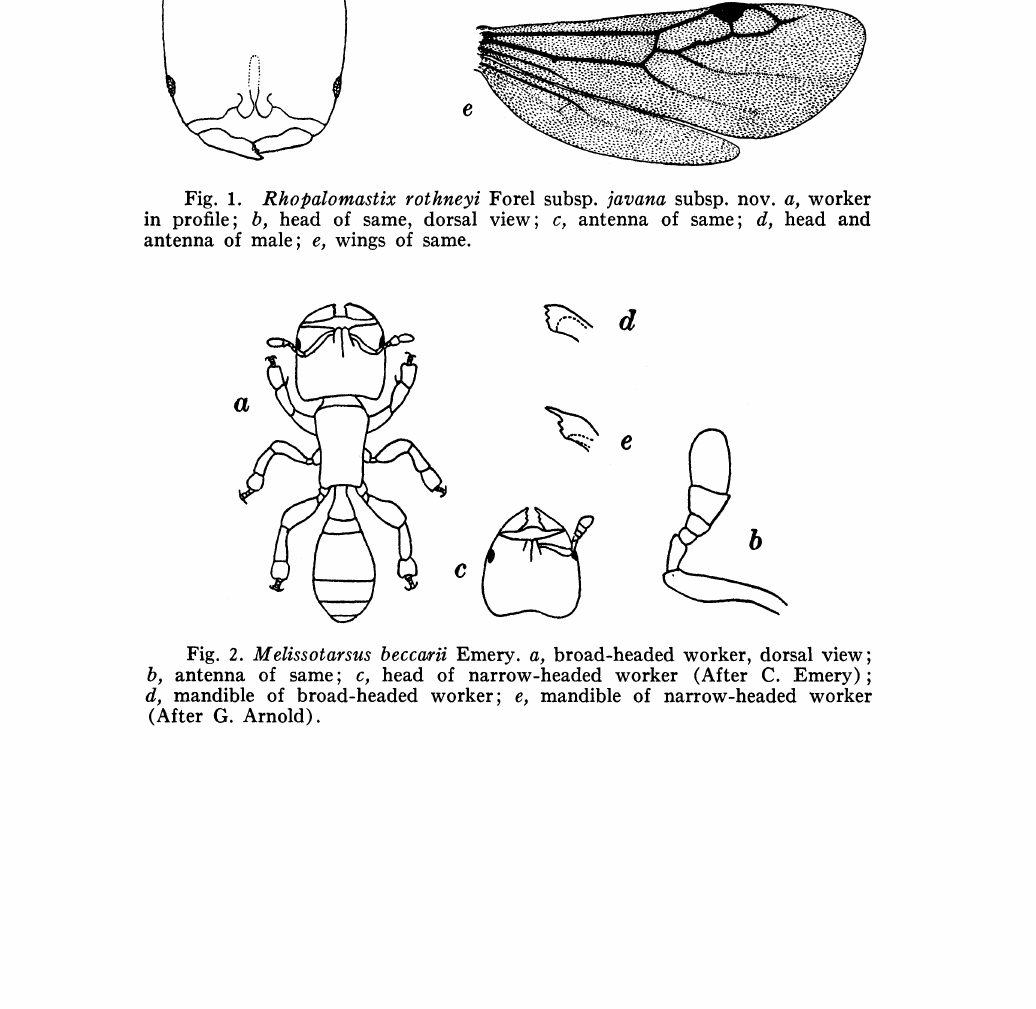
Fig. 1. Rhopaloraastix rothneyi Forel subsp. )avana subsp, nov. a, worker in profile; b, head of same, dorsal view; c, antenna of same; d, head and antenna of male; e, wings of same.